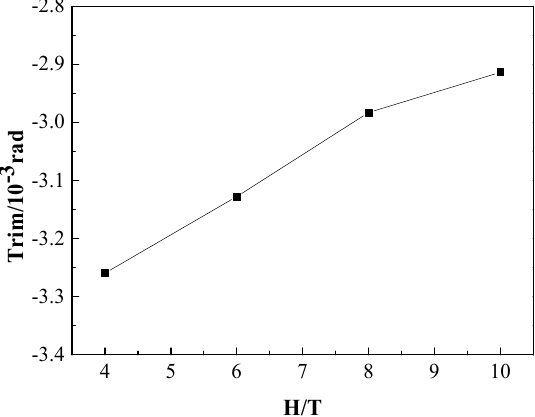
Figure 12. The trim angle with different depth/draft ratios of KCS scaled model (H/T).